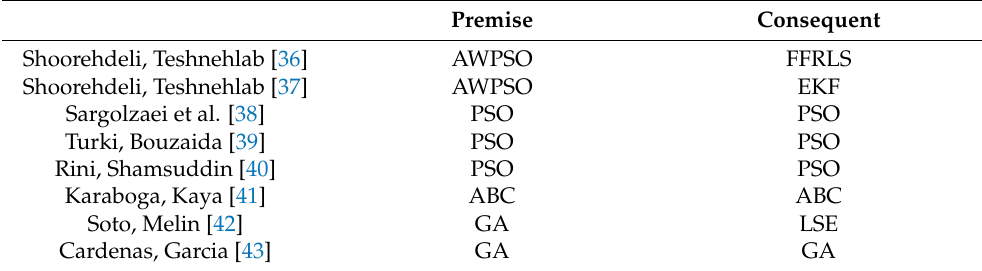
Table 2. Summary of studies based on metaheuristic algorithms for ANFIS training. Premise